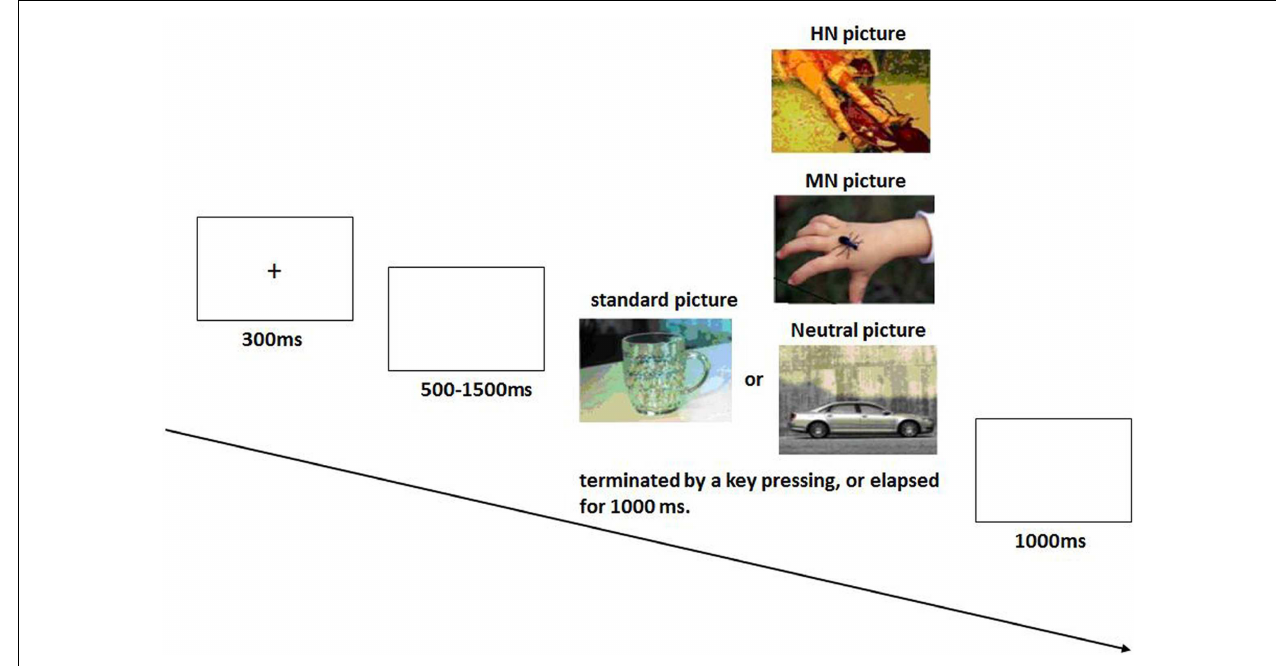
FIGURE 1 | The diagram of our experimental task (Yuan et al.,